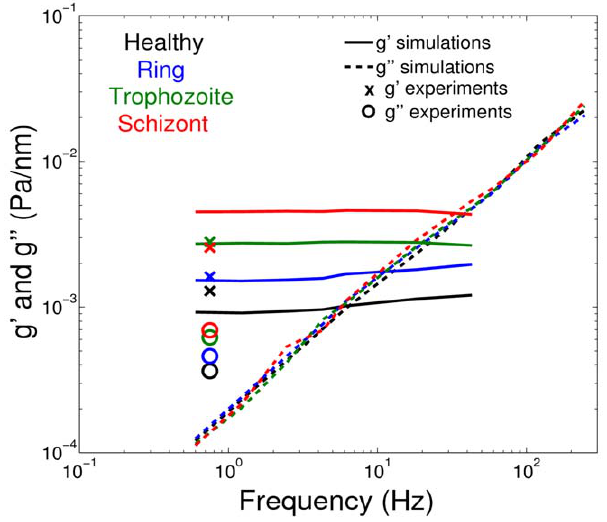
Figure 2. Components ( g ’ and g ’’ ) of the complex modulus for healthy RBCs and Pf-RBCs at different stages at T ~ 23 o C obtained from STC simulations. Experimental data [5] for the frequency 0 : 75 Hz are drawn in symbols. The shear moduli of Pf-RBCs for different stages are given in Table 1. The bending stiffness and the membrane viscosity in all cases are set to 2 : 4 | 10 { 19 J and 0 : 022 Pa : s , respectively.